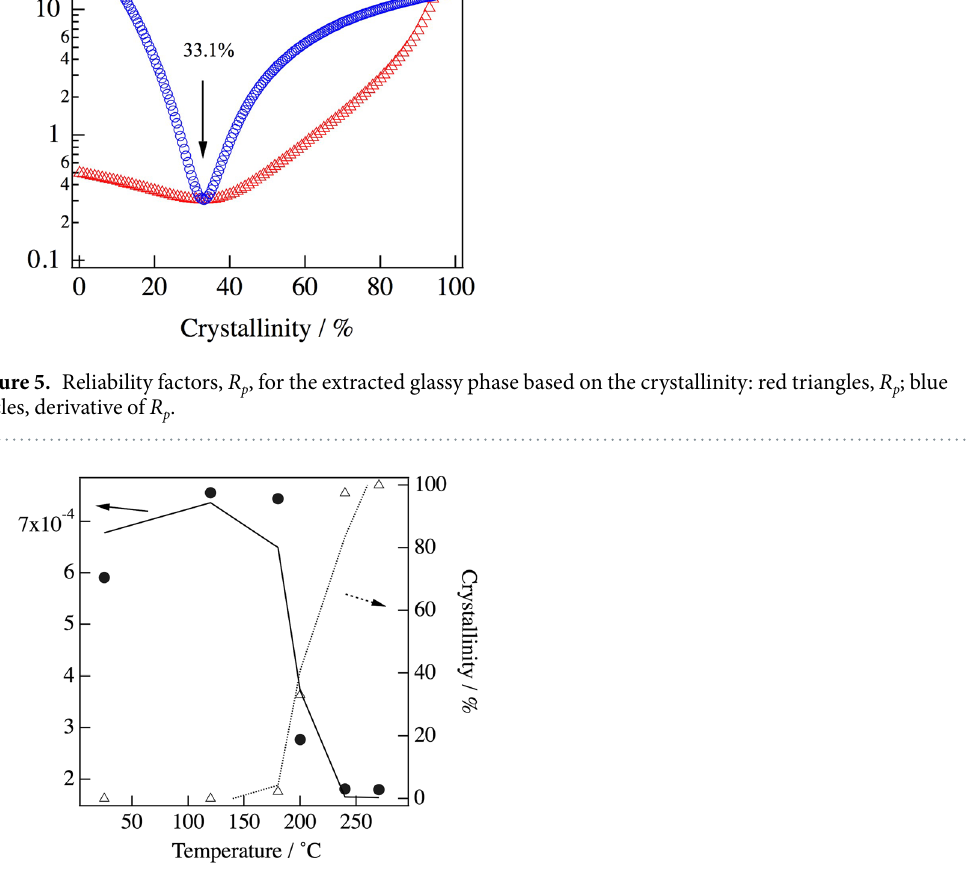
Figure 6. Crystallinity obtained from d-PDF under each annealing condition and the lithium ionic